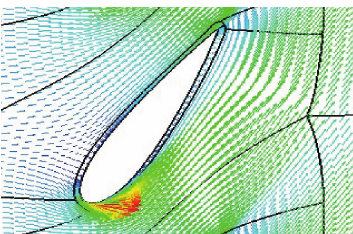
Figure 12: Velocity vector distribution of 0018 at 60 ∘ setting angle.